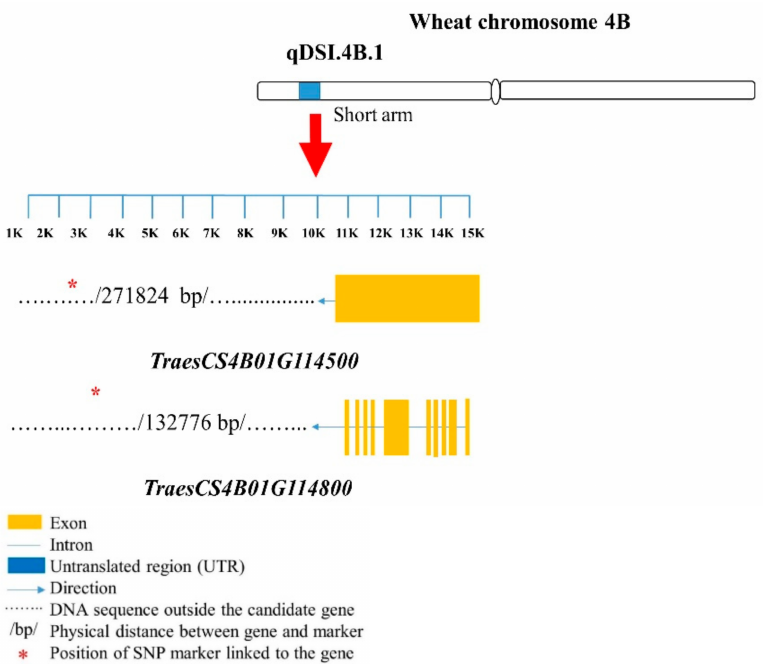
Figure 2. Structures of candidate genes in the qDSI.4B.1 genomic region (GR). SNP markers are located in different positions of the genes. The genes were identified based on the 90K wheat microar- ray assessment of near-isogenic lines with contrasting root traits. SNP markers are located in different positions of the genes. Structural information of the genes and SNP markers were obtained from a wheat genome database (https://urgi.versailles.inra.fr/jbrowseiwgsc/gmod_jbrowse/, accessed on 2 March 2021). The measuring bar indicates the DNA length in kilo base pairs